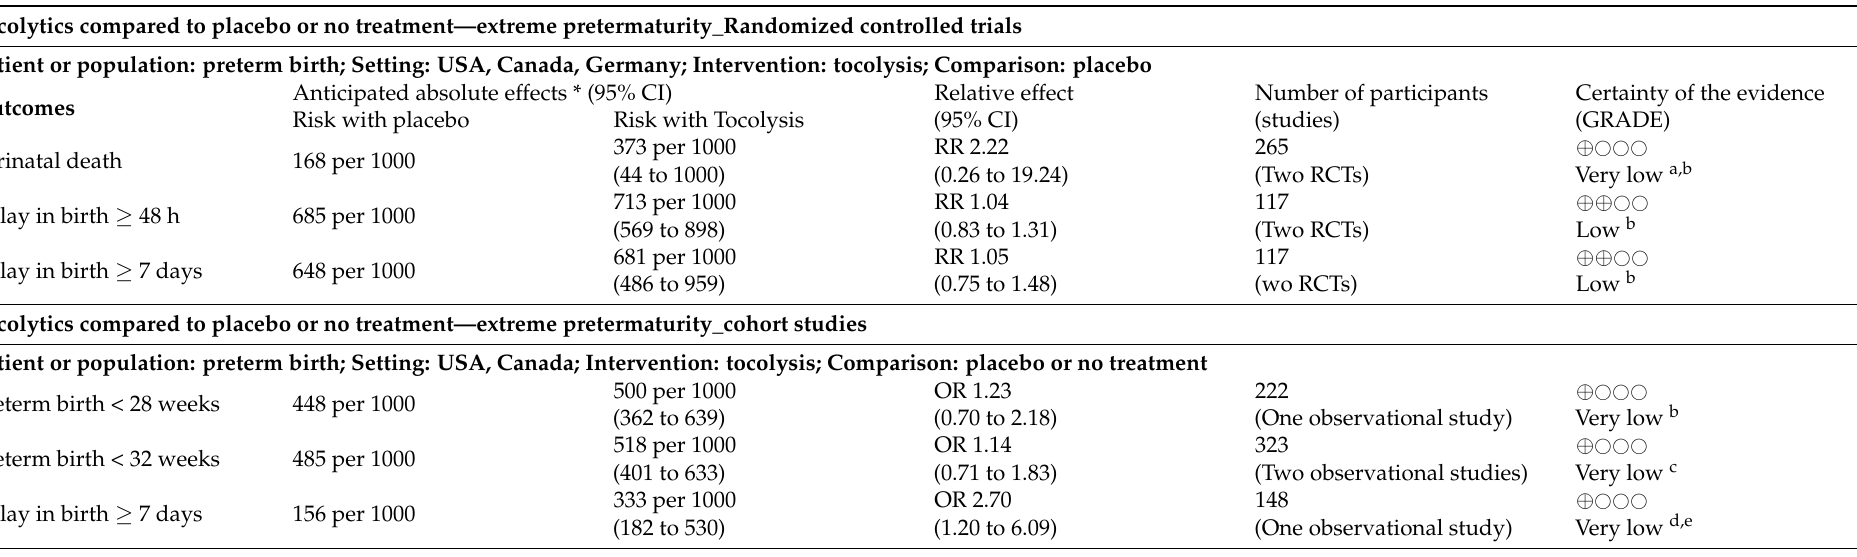
Table 2. Summary of findings table on tocolysis for women with extremely preterm